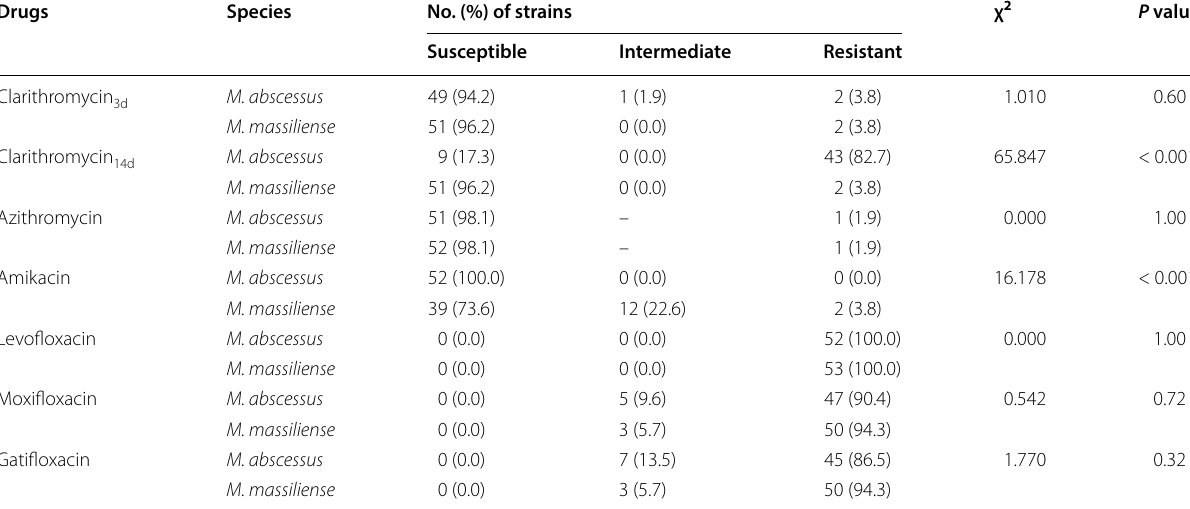
Table 3 Results of drug susceptibility testing against M. abscessus and M. massiliense